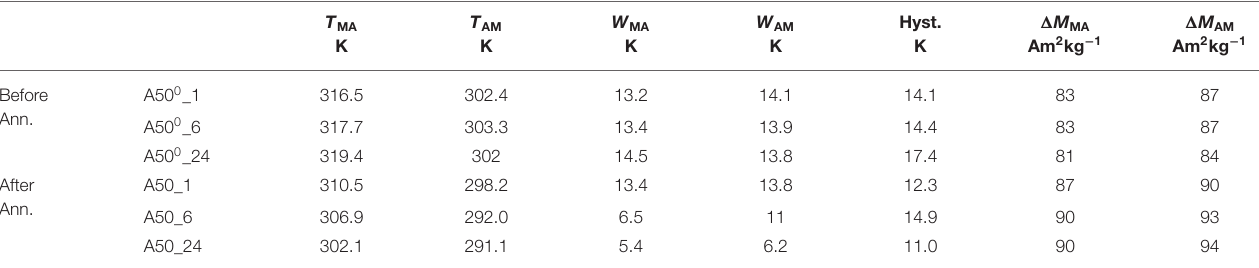
W AM W MA T AM T MA 1 M AM 1 M MA Hyst. Am 2 kg − 1 Am 2 kg − 1 K K K K K